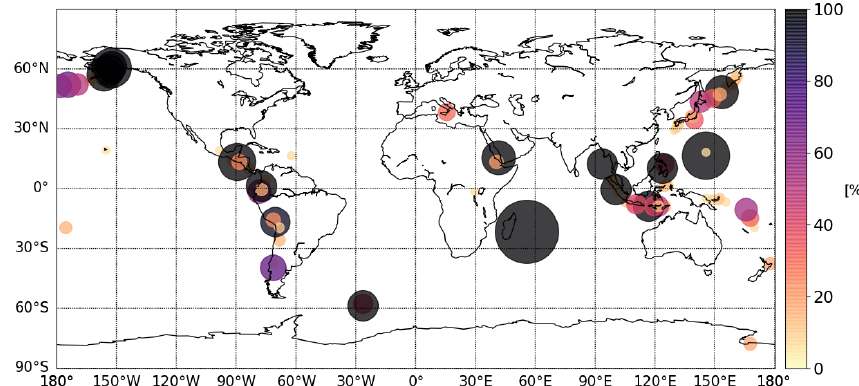
Figure 14. Map of U V , Y /E V , Y ratio of SO 2 emissions (in percent) in Carn et al. (2017). The size of the circles is proportional to the value of the ratio, which is also represented by the color. Table 6. As in Table 5 but for CA_MIN, CA_MAX and CA_RAND simulations. Sulfur emission SO 2 burden Sulfate burden Sulfur deposition